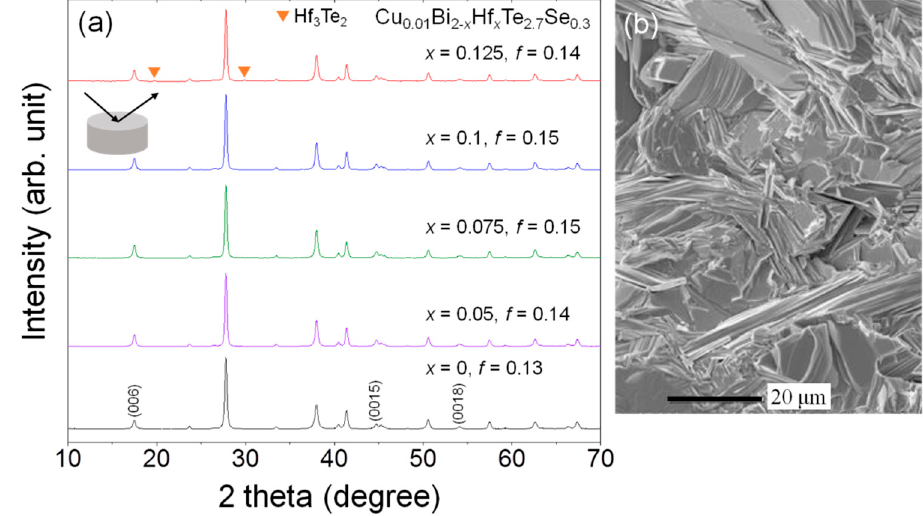
Figure 1. ( a ) X-ray di ff raction patterns of the spark plasma sintered (SPSed) Cu 0.01 Bi 2- x Hf x Te 2.7 Se 0.3 ( x = 0, 0.05, 0.075, 0.1, 0.125) bulks in the planes perpendicular to the SPS press direction. ( b ) SEM image of the fractured surface of the SPSed Cu 0.01 Bi 1.9 Hf 0.1 Te 2.7 Se 0.3 .